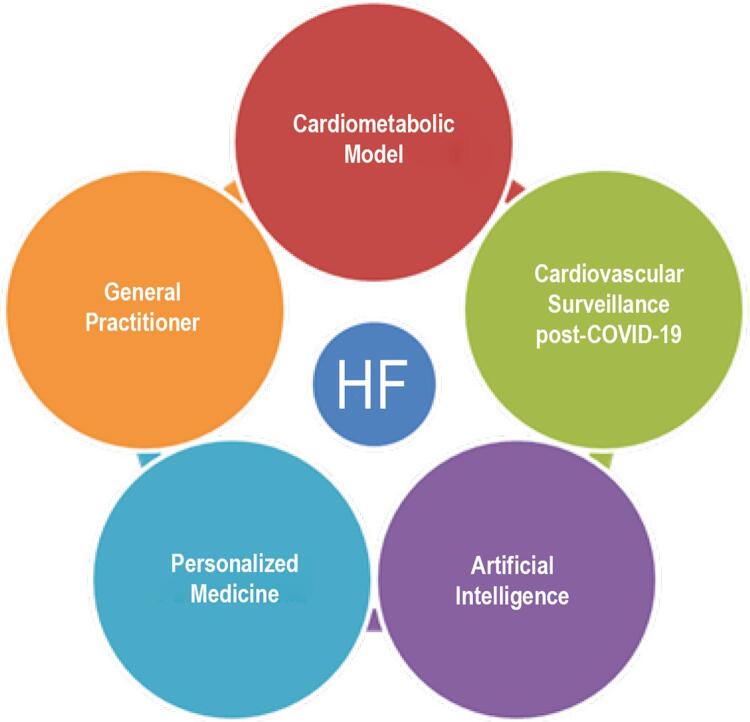
– Challenges of DEIC 2020–30